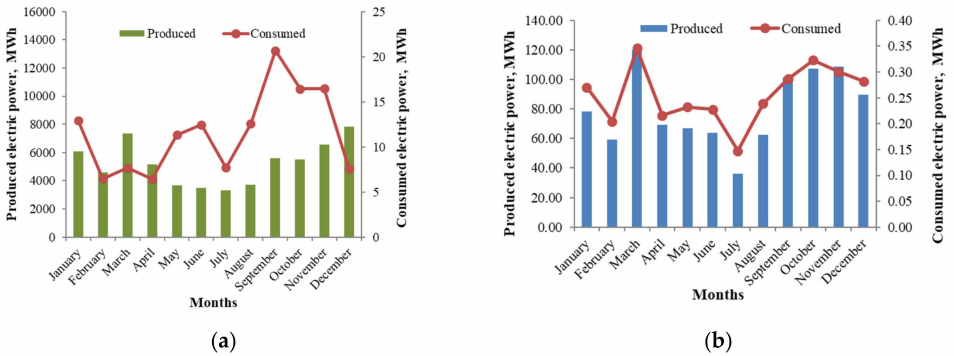
Figure 5. The average values of the balance of the produced and consumed electric power per year: ( a ) in > 10 MW capacity of the wind turbines; ( b ) in < 10 MW capacity of the wind